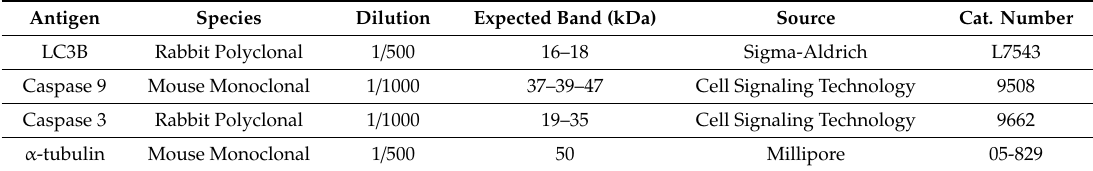
Table 1. Antibody used for Western blot